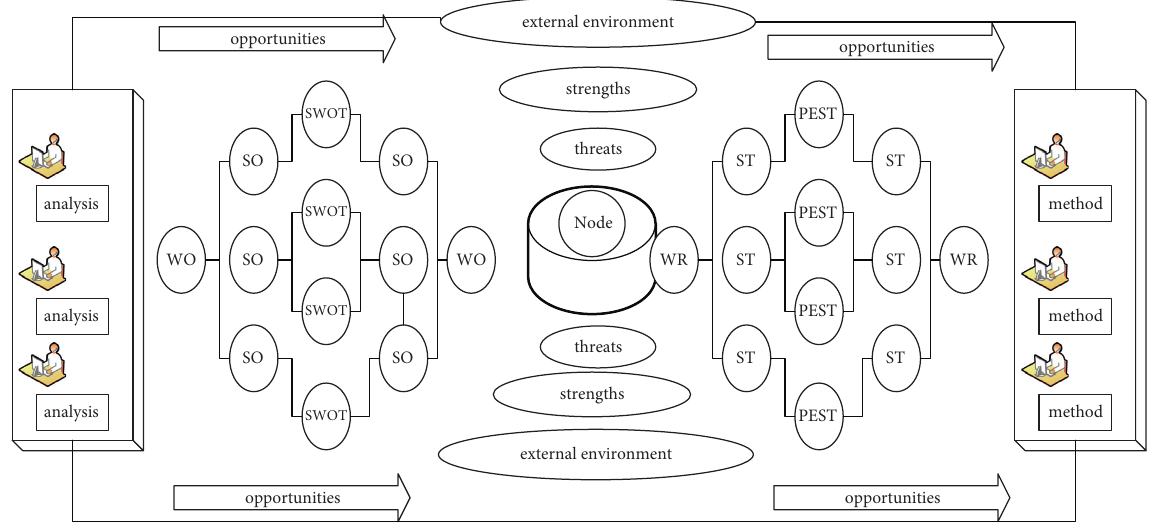
Figure 1: SWOT-PEST hierarchical